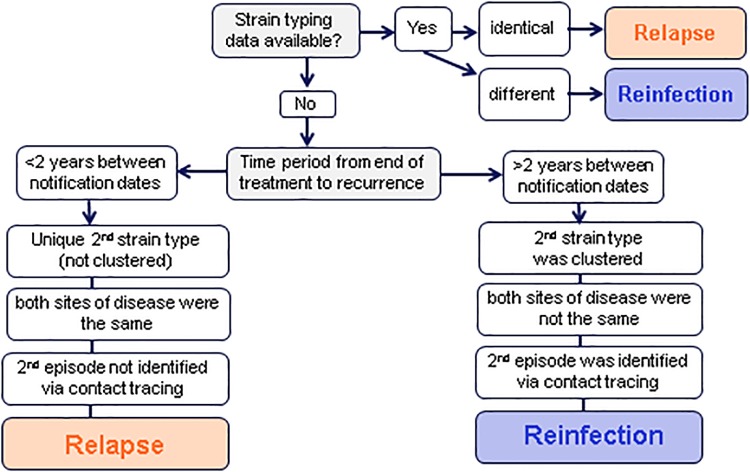
Categorising recurrent TB cases into relapse and reinfection.